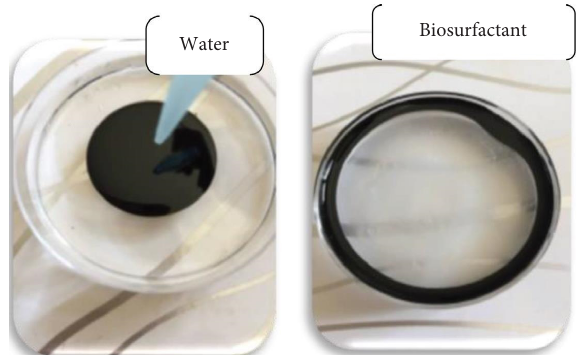
Figure 3: Oil spreading assay technique showing results of the most promising biosurfactant producers. Te oil layer was dis- placed by biosurfactant. Water was a negative